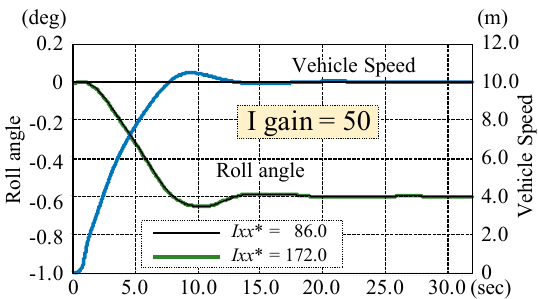
Figure 8. No roll vibration phenomena are observed (I = 100 → 50).